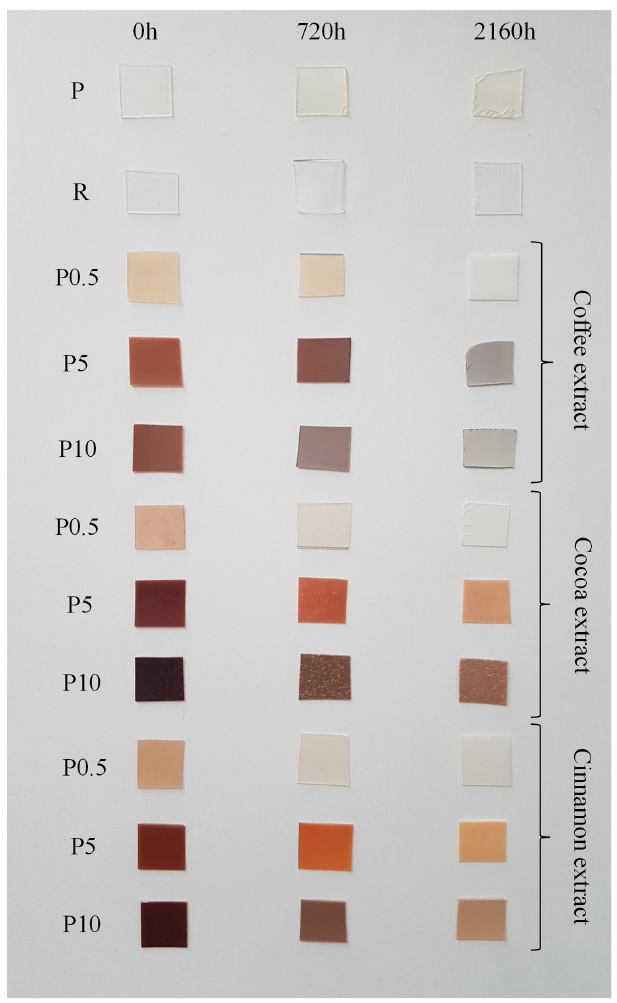
Figure 1. Photos of selected samples before and after the aging process.